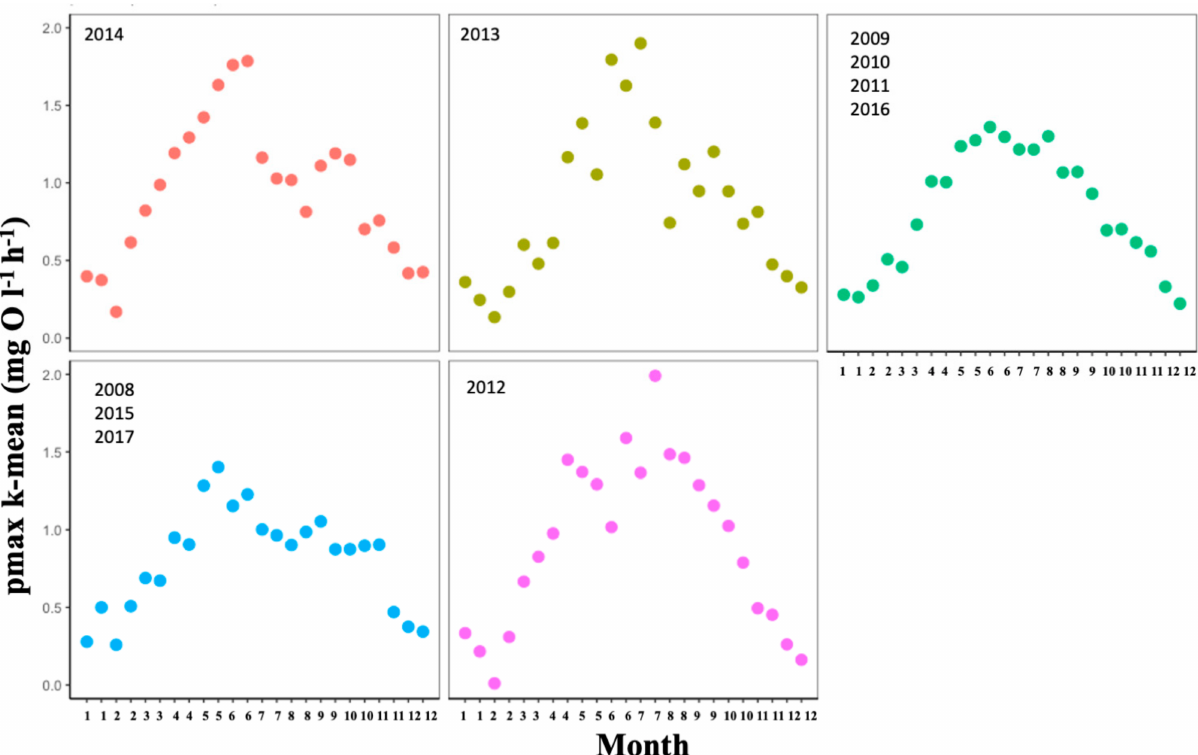
Figure 6. K-means clustering results, showing values of centroids pmax for each fortnight for each cluster. Years belonging to each cluster are displayed in the top-left corner of each